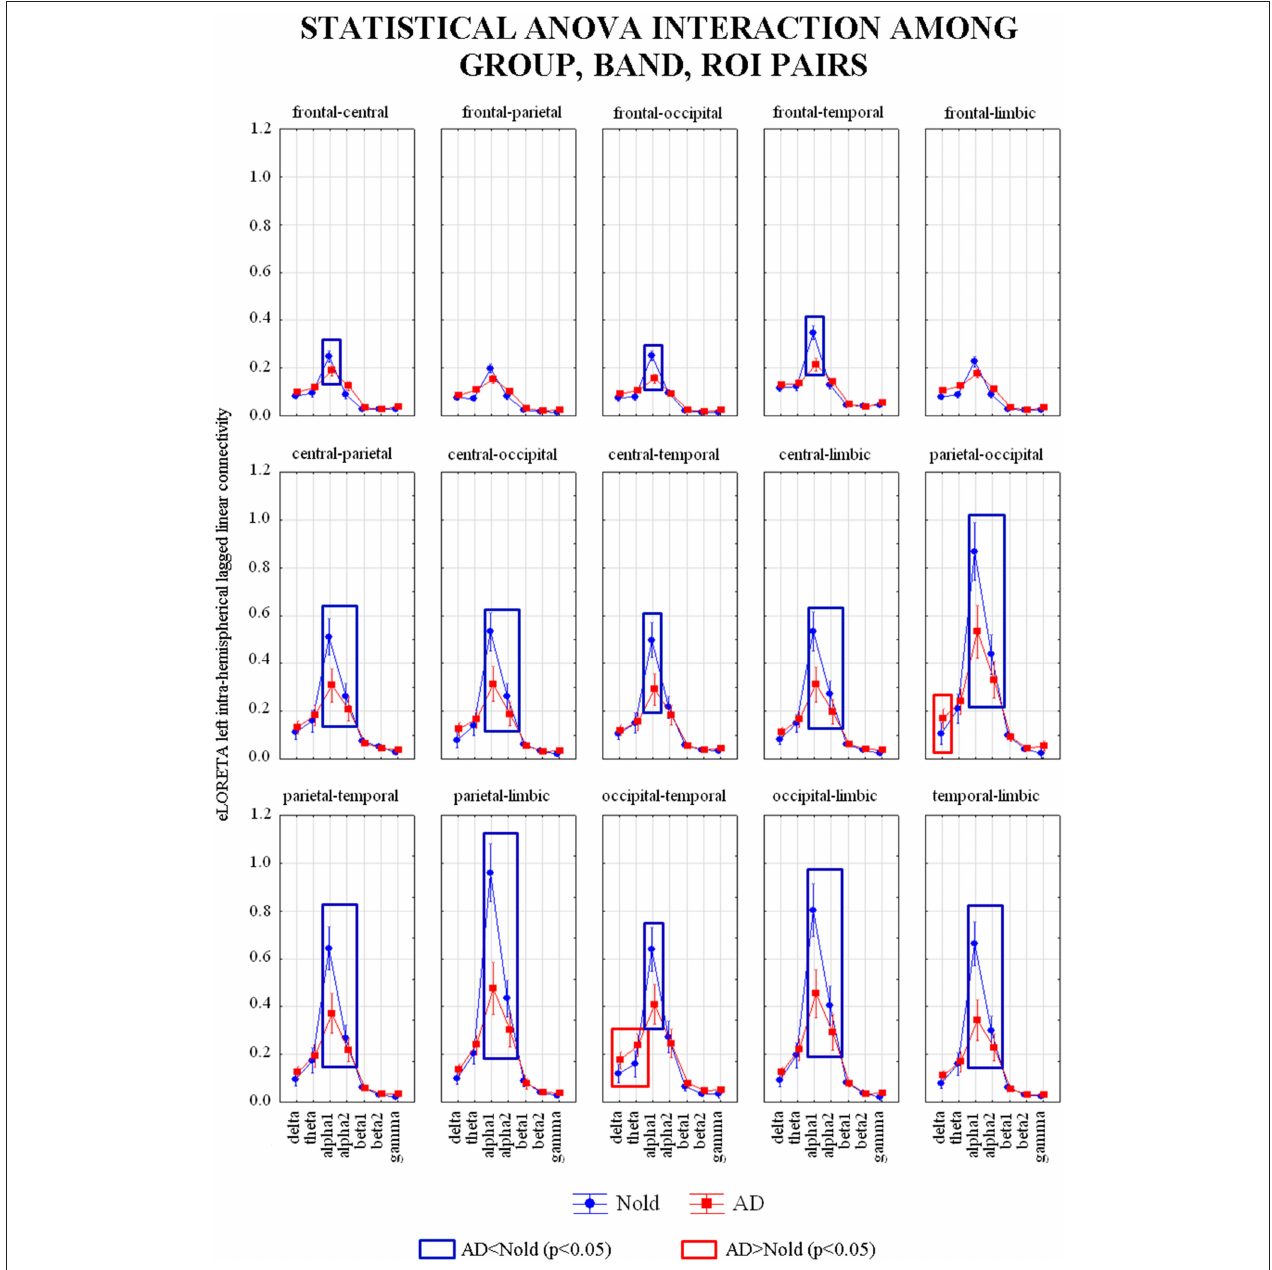
FIGURE 4 | Diagram showing the grand average of the EEG intra-hemispherical lagged linear connectivity computed between each pair of regions of interest (ROI) in the left hemisphere. These values refer a statistically significant ANOVA interaction [ F (84 , 18312) = 8.5942, p < 0.0001] among the factors Group (AD, Nold), ROI pairs (frontal-central, frontal-parietal, frontal-occipital, frontal-temporal, frontal-limbic, central-parietal, central-occipital, central, temporal, central-limbic, parietal-occipital, parietal-temporal, parietal-limbic, occipital-temporal, occipital-limbic, and temporal-limbic), and Band (delta, theta, alpha 1, alpha 2, beta 1, beta 2, gamma). Subjects’ age, education, IAF, and gender were used as covariates. Legend: the rectangles indicate the ROI pairs and frequency bands in which connectivity values presented the pattern Nold 6= AD (Duncan test, p < 0.05).